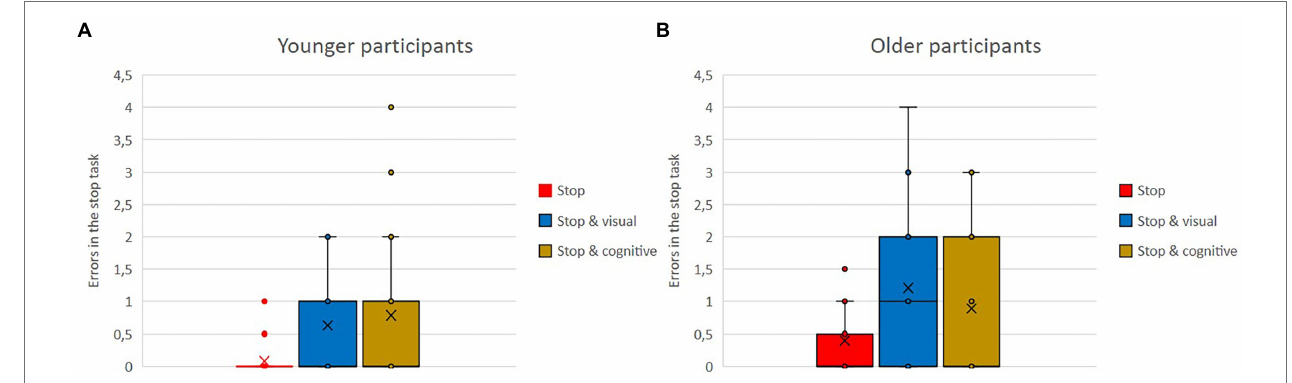
FIGURE 4 | (A,B) Means of errors in the stop task, as single vs. dual-task conditions with either the visual or the cognitive secondary task for the older and the younger